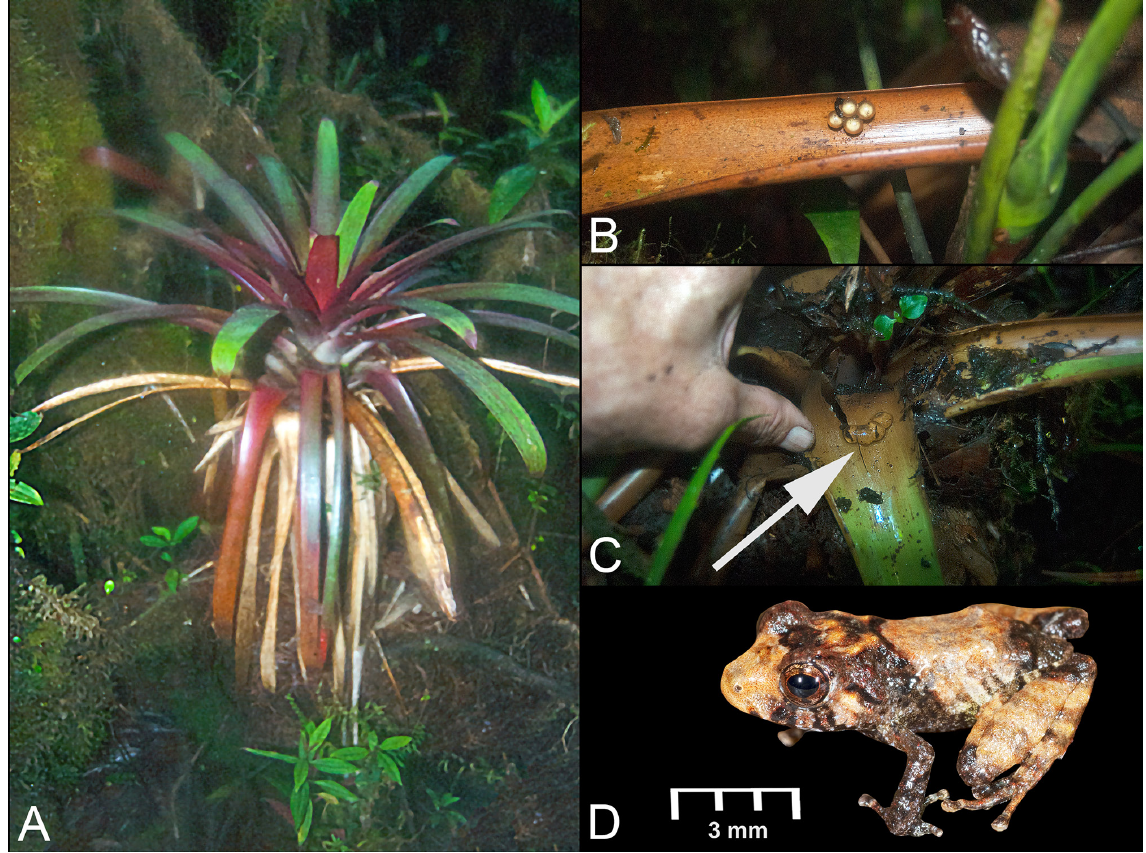
Fig. 6. A . Guzmania cf. sphaeroidea (André) André ex Mez, an arboreal bromeliad species used as egg deposition site by Pristimantis marmoratus (Boulenger, 1900) in the Wokomung Massif. B . Egg clutch of Pristimantis marmoratus deposited on a leaf of the arboreal bromeliad Guzmania cf. sphaeroidea in the Wokomung Massif. C . Egg clutch of Anomaloglossus beebei (Noble, 1923) (white arrow) deposited in the phytotelmata of the same plant as in B. D . Dorsolateral view of IRSNB 17916, 11.3 mm SVL, a juvenile of P. marmoratus collected on the slopes of Maringma-tepui, Guyana. Photographs A–C by DBM, D by